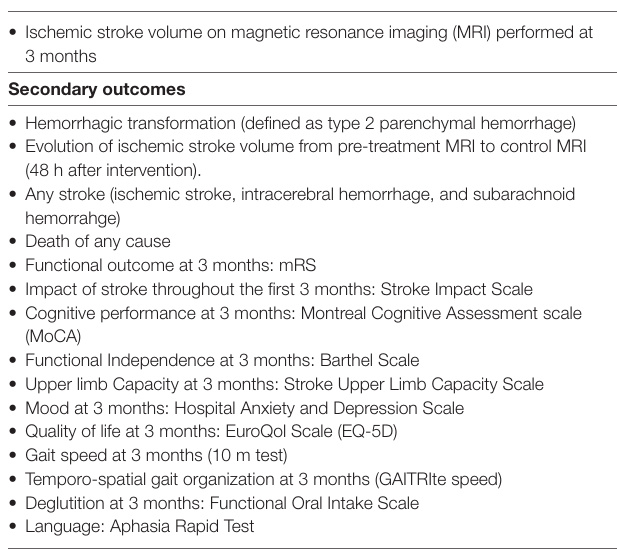
tablE 2 | Study outcomes assessed. Primary outcome